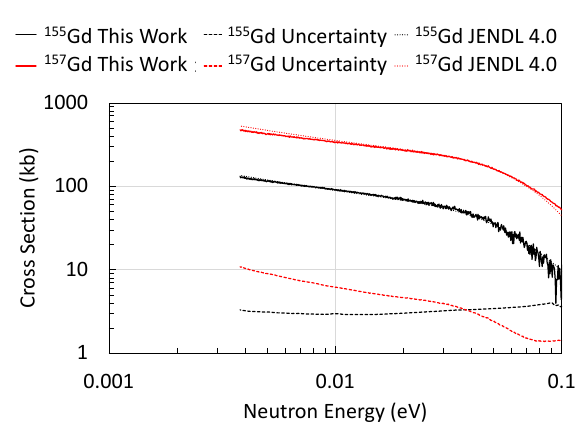
Figure 1. TOF spectra of the 155 Gd and 157 Gd samples, the Al Figure 3. Derived preliminary capture cross sections of 155 Gd foils and Blank. The TOF time bin is 25 µ s. Each TOF spectrum and 157 Gd and uncertainties with comparison to the values of was normalized with the number of the proton beam pulses. JENDL-4.0 at 300 K.